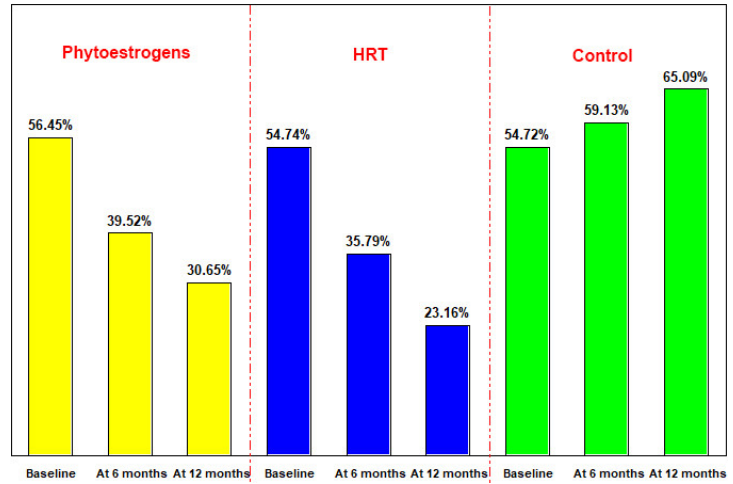
Figure 1. The distribution of cases according to D-Pyr values > 6 nM/mM creatine.